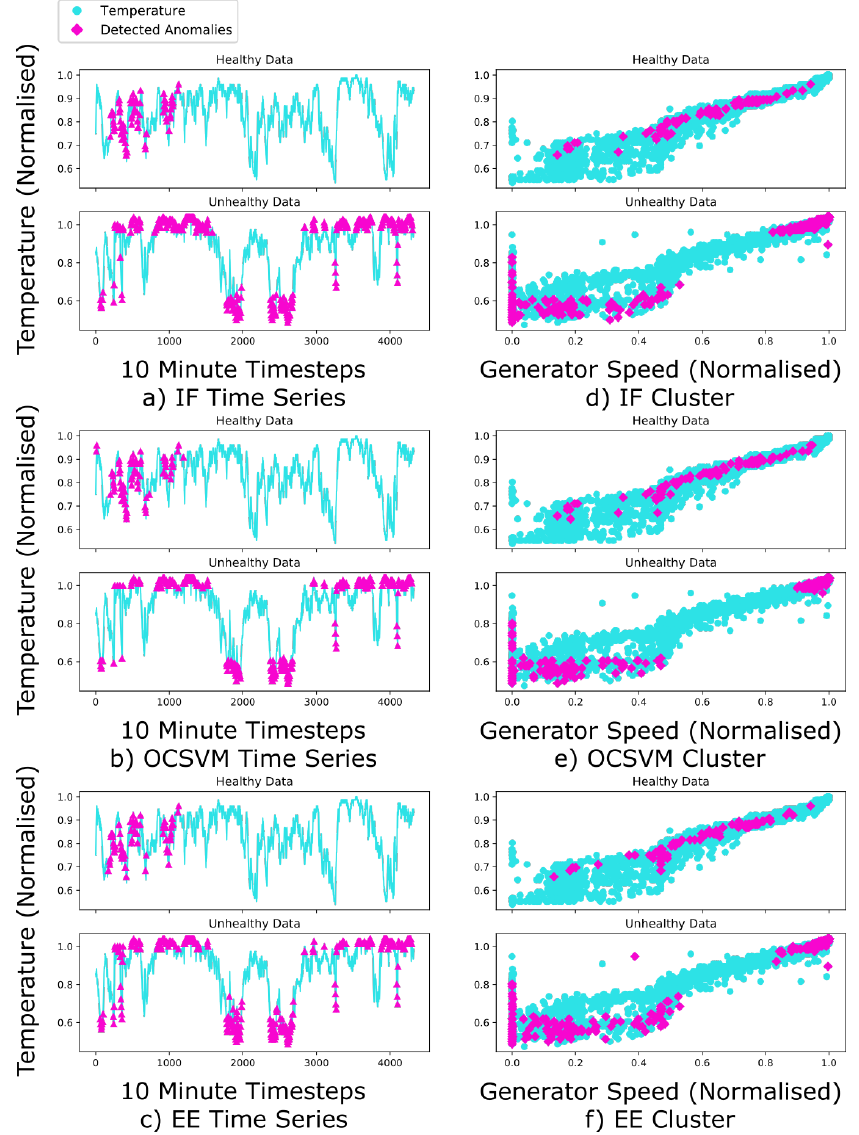
Figure 3. These figures show anomalies for the specific training regime with normalised data from the temperature target with four inputs. ( a – c ) The blue (light) line shows the normalised main bearing temperature data. The pink (dark) triangles show when anomalies were detected during the two months. ( d – f ) The blue (light) circles shows the normalised main bearing temperature data. The pink (dark) diamonds show when anomalies were detected during the two